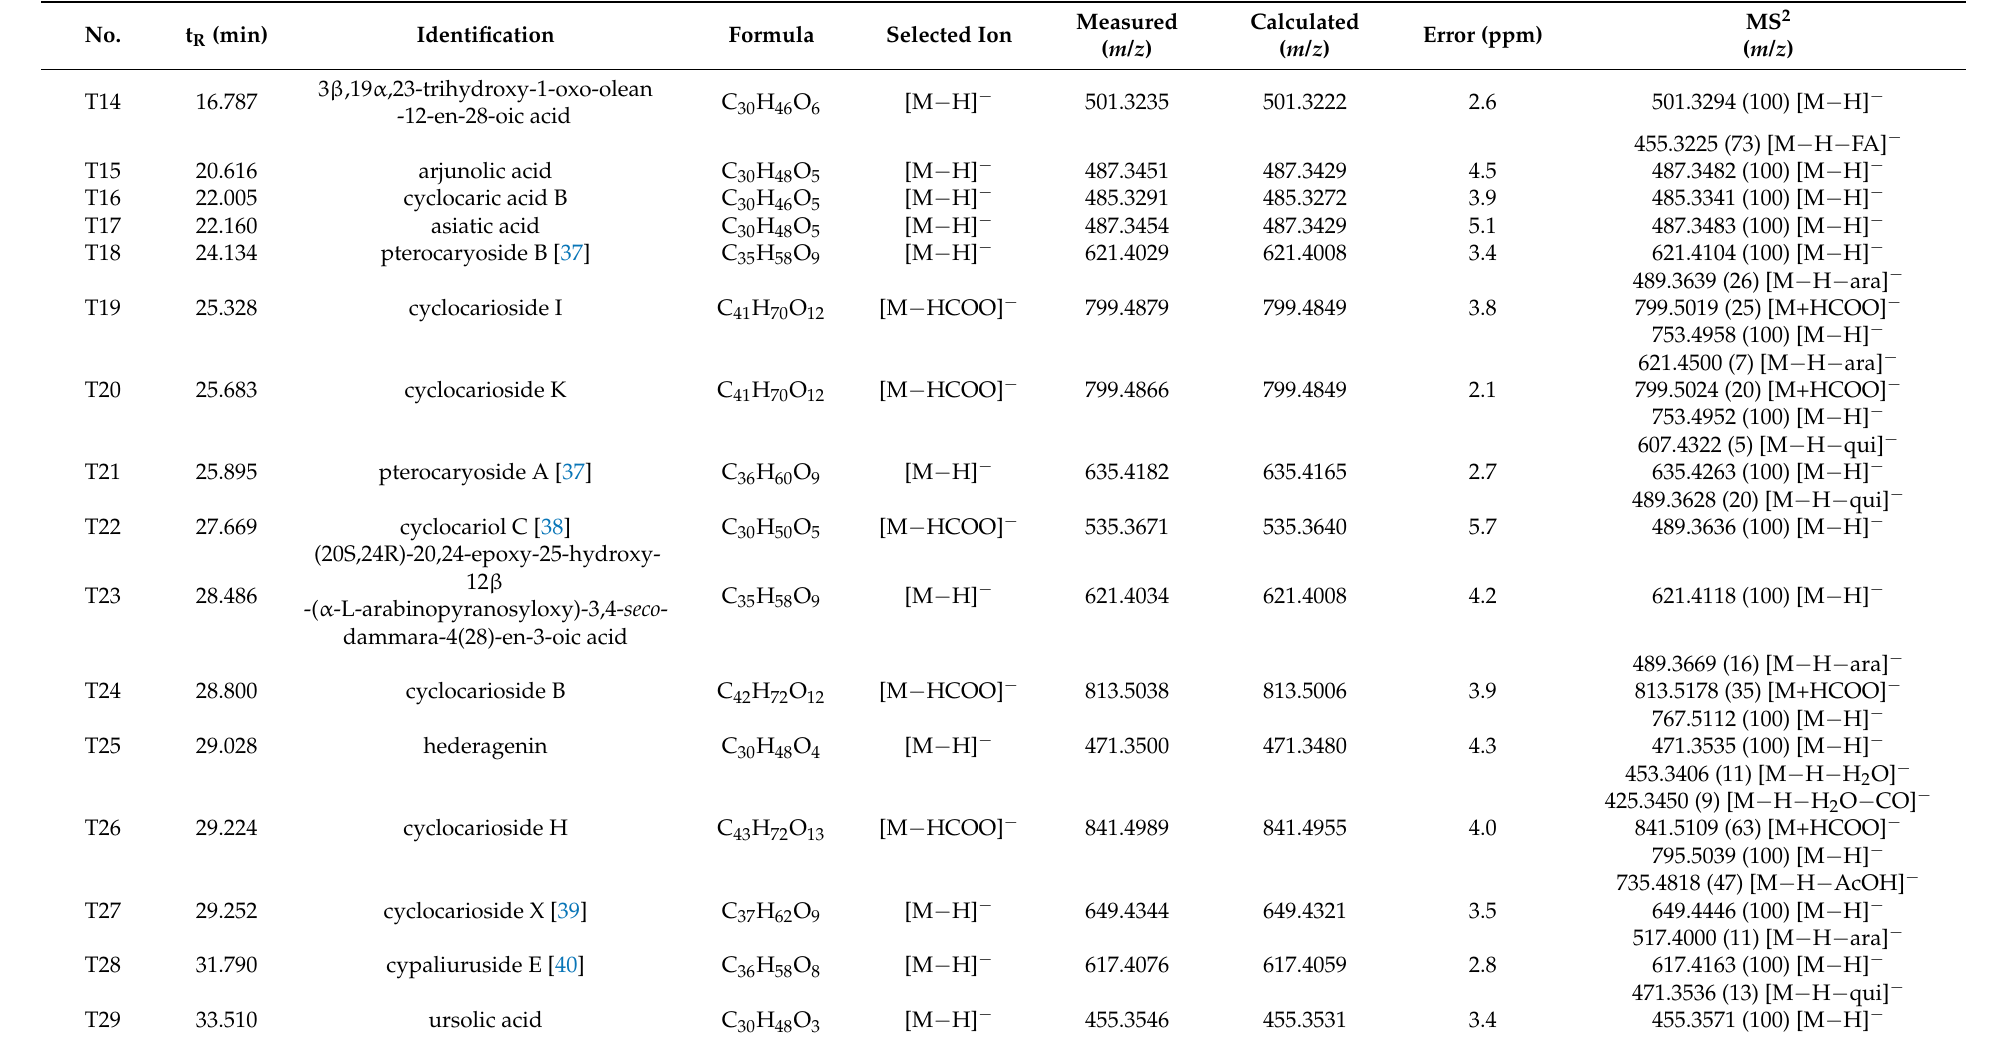
Table 3. Identification of the chemical constituents in CPT by